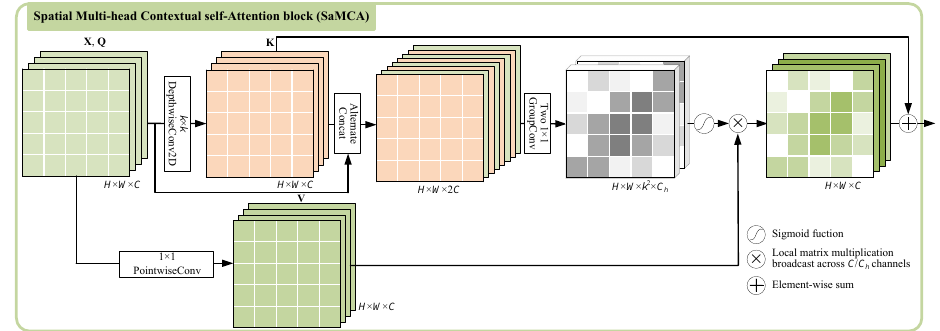
Figure 3. Architecture of the spatial multi-head contextual self-attention (SaMCA).